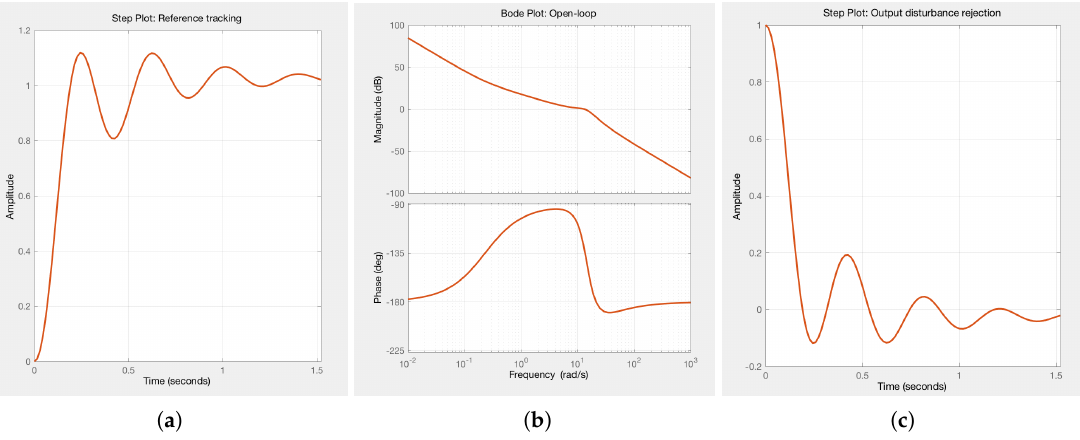
Figure 9. Performance of PI control. ( a ) step response of traditional PI control; ( b ) Bode diagram of traditional PI control; ( c ) output disturbance rejection of traditional PI control.